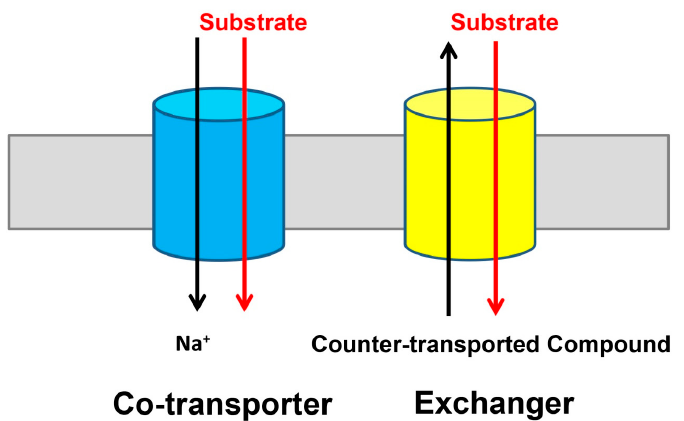
Figure 1. Two modes of transport identified in the divalent anion/Na + symporter (DASS) proteins. Many DASS proteins, including VcINDY and five human DASS transporters, function as Na + -dependent co-transporters or symporters ( left ). Whereas, the fruit fly INDY, which is the founding member of the DASS family, appears to be a Na + -independent exchanger or antiporter ( right ). For simplicity, the DASS proteins are drawn as cylinders (blue and yellow) and the membrane as a grey rectangle.